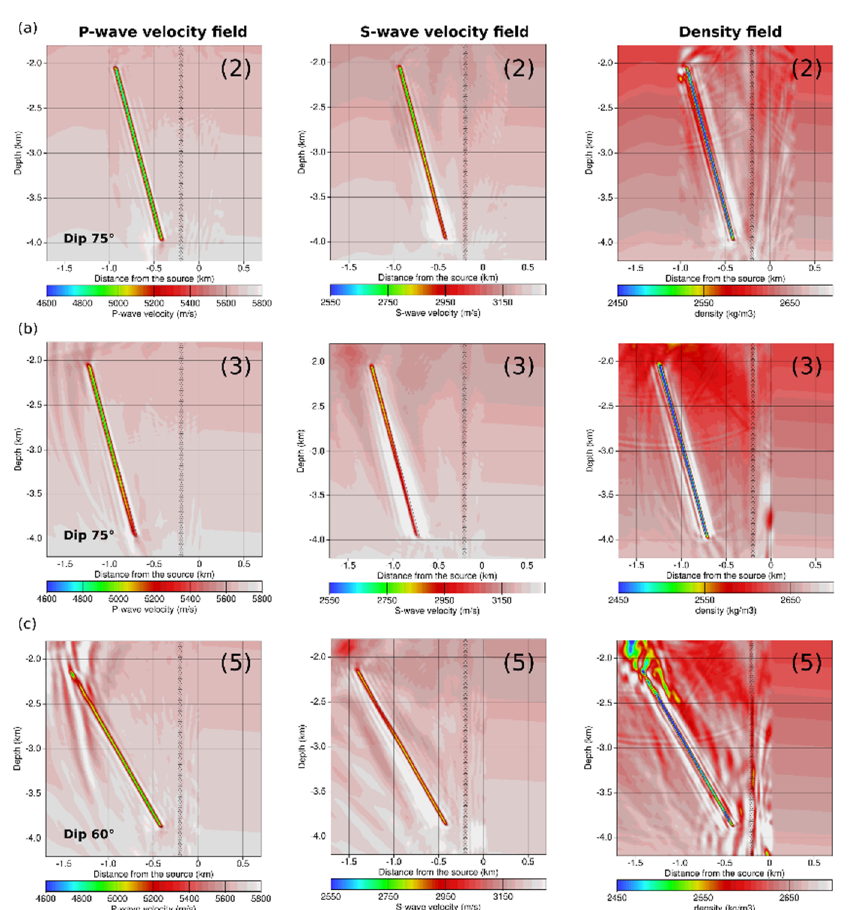
Figure 9. The retrieved P-wave velocity field (left), S-wave velocity field (center) and density field (right) for faults ( a ) 2, ( b ) 3 and ( c ) 5 (Figure 7). The faults 2 and 5 are 200 m far from the closest receivers whereas fault 3 is 500 m far from the closest receivers in the lower part of the fault. We show only the target area showed by the white rectangle in Figure 2c.